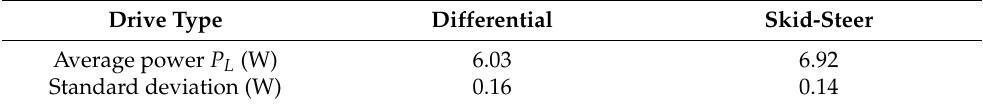
Table 2. The logical power experimental results.